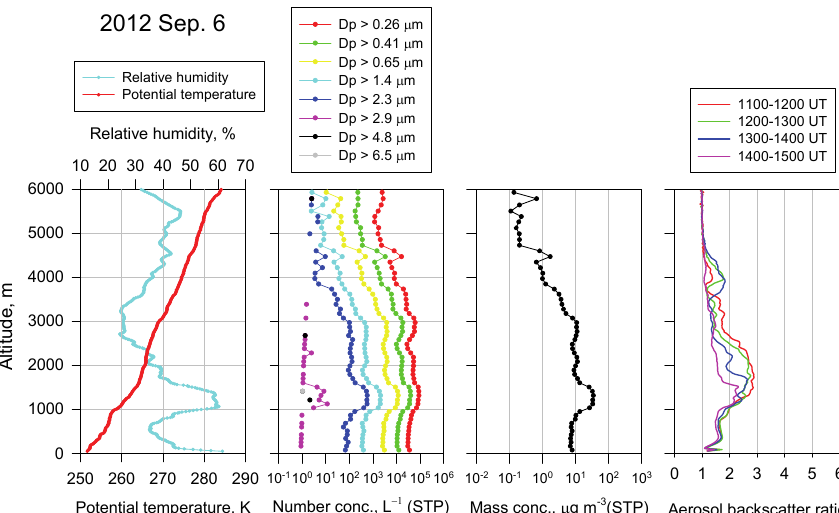
Fig. 5. Vertical variations of air temperature, relative humidity, aerosol number concentration, mass concentration, and backscatter ratio over Syowa Station on 6 September